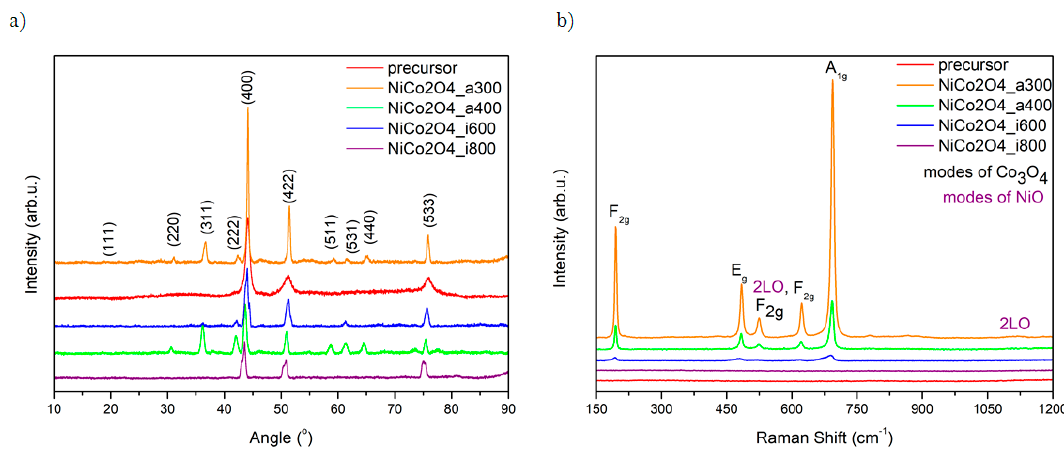
Figure 2. XRD patterns ( a ) and Raman Spectra ( b ) of obtained samples.